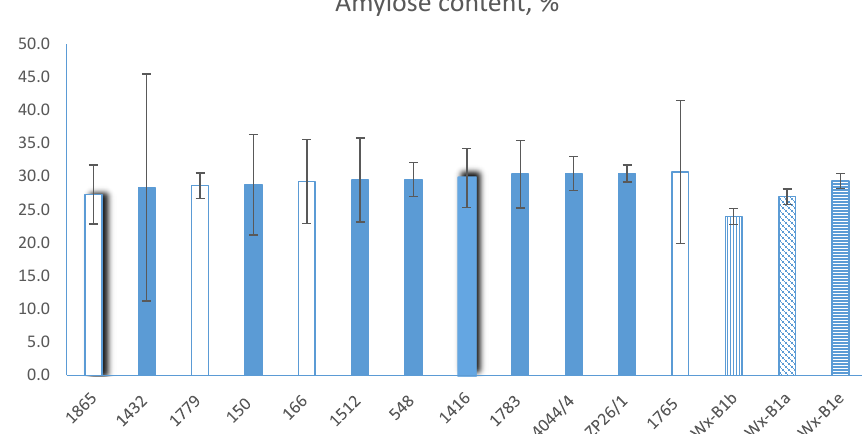
Figure 5. The amylose content in the accessions of the wheat–wheatgrass hybrids (%). Blue solid fill, type 1 of WXTH amplification; no fill, type 2 of WXTH amplification; pattern fill, common wheat control accessions: vertical pattern, Wx-B1b ( null allele); diagonal pattern, Wx-B1a (Nemchinovskaya 56); horizontal pattern, Wx-B1e . Chart columns with shadows (1416 and 1865) show wheat–wheatgrass accessions with putative wheatgrass bands in SDS-PAGE electrophoregram. The differences are estimated using t -test, bars show confidence interval ( p = 0.05).